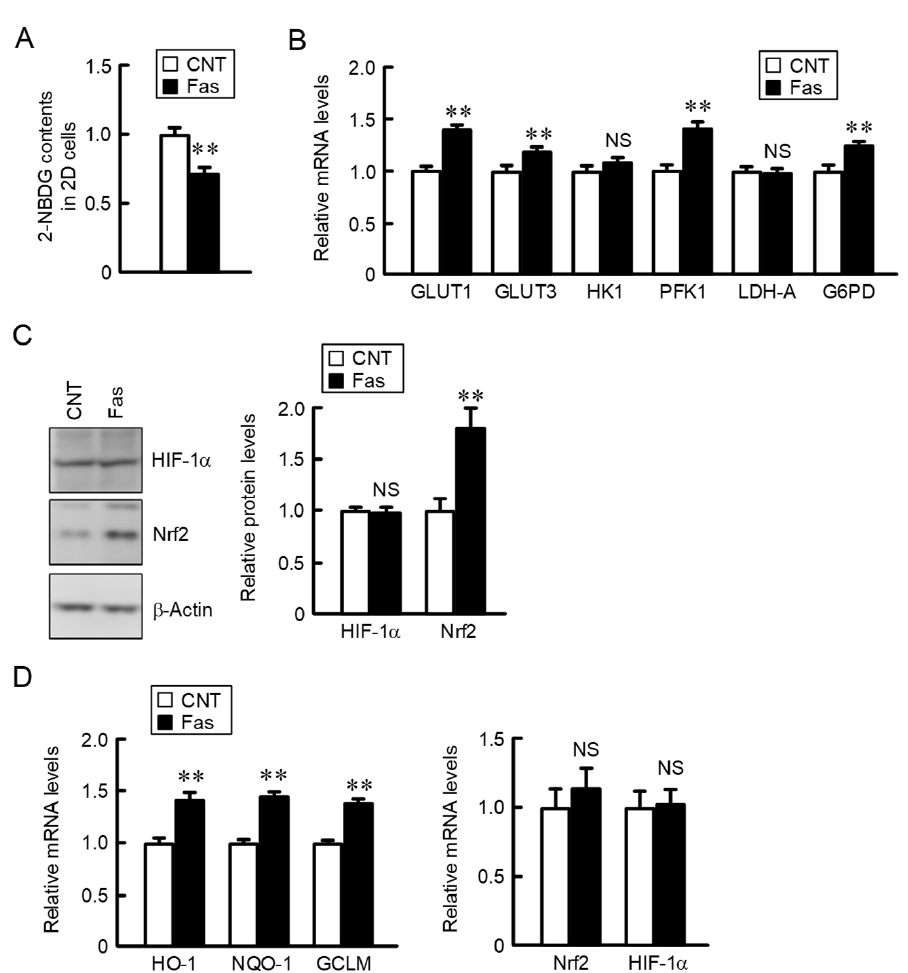
Figure 5. Increase in the expression of Nrf2 and Nrf2-related genes by fasentin in 2D monolayer cells. A549 cells were cultured on 96-well plates ( A ) or 6 cm dishes ( B – D ) for 4 days. The cells were incubated in the absence (CNT) and presence of 10 µ M fasentin (Fas) for 24 h ( A , C ) or 6 h ( B , D ). ( A ) The cells were incubated with 10 µ M 2-NBDG for 60 min after the treatment with Fas. The fluorescence intensity of 2-NBDG was measured using an Infinite F200 PRO microplate reader and is represented relative to the values in CNT. ( B , D ) Real-time PCR was performed using primer pairs as listed in Table 1. The mRNA levels are represented relative to the values in CNT. ( C ) Western blotting was performed using anti-HIF-1 α , anti-Nrf2, and anti- β -actin antibodies. The protein levels are represented relative to the values in CNT. n = 3–4. ** p < 0.01 compared with CNT. NS, p > 0.05.